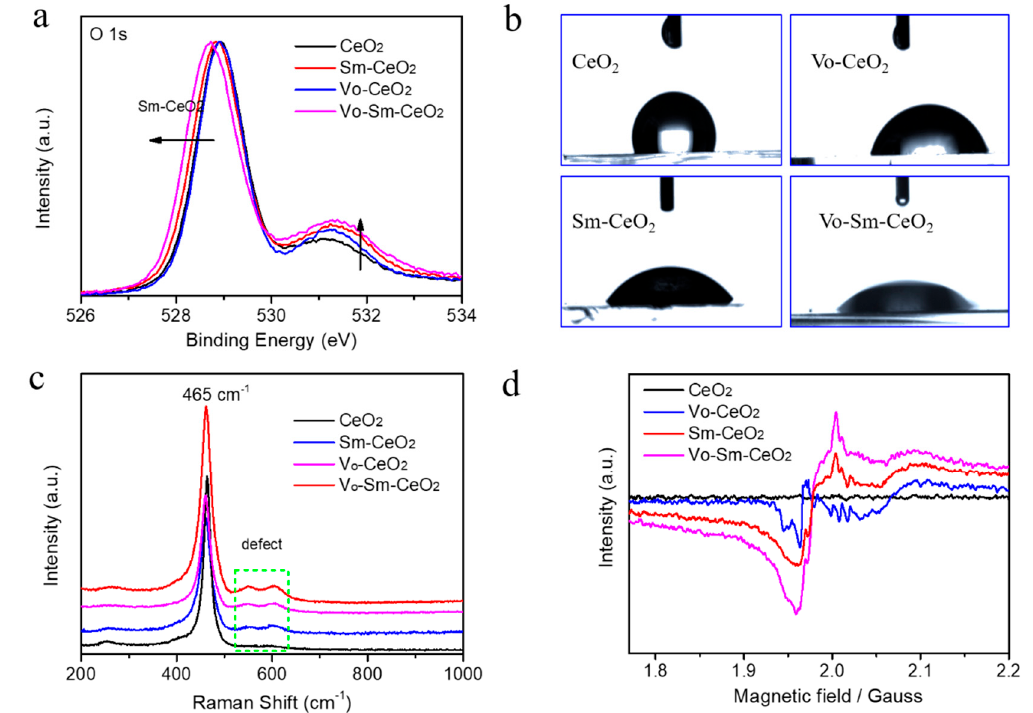
Figure 3. ( a ) O 1s XPS spectra. ( b ) Contact angles with water droplet, ( c ) Raman spectra, and ( d )